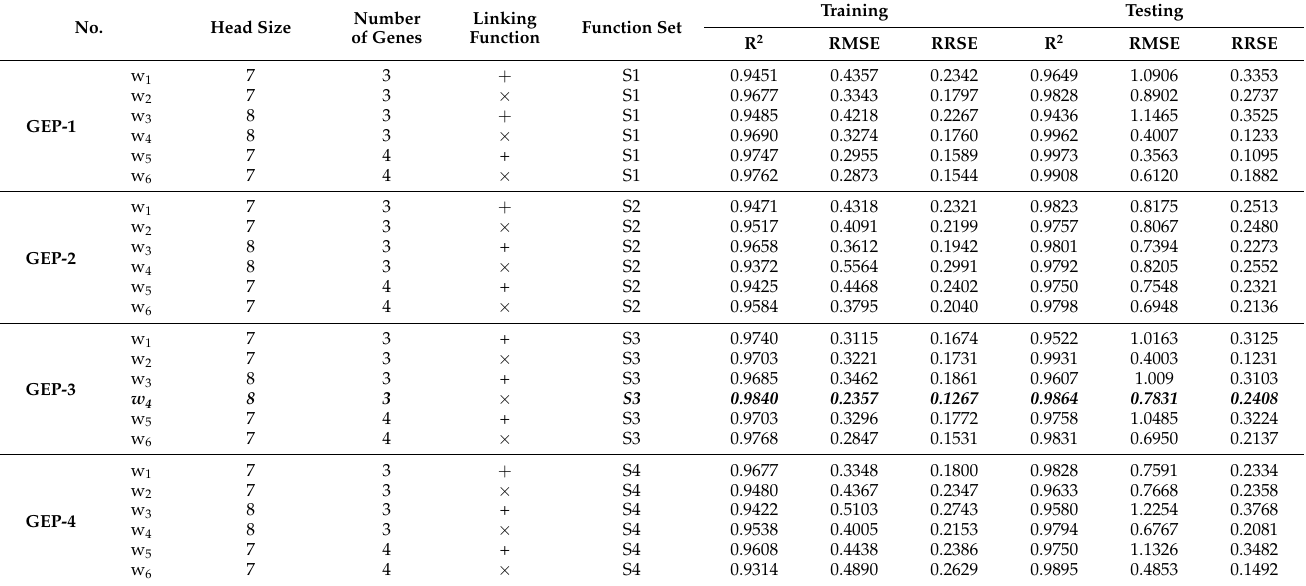
Table 4. The statistical performances of the GEP models in RMSE, RRSE, and R 2